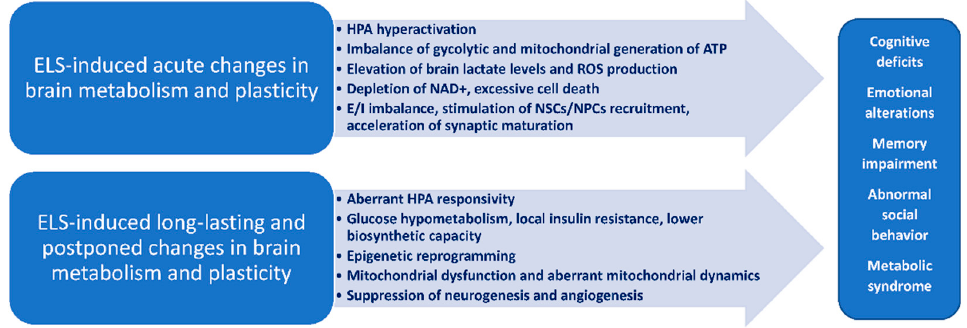
Figure 3. Acute and long-lasting/postponed changes in brain metabolism and plasticity induced by ELS.